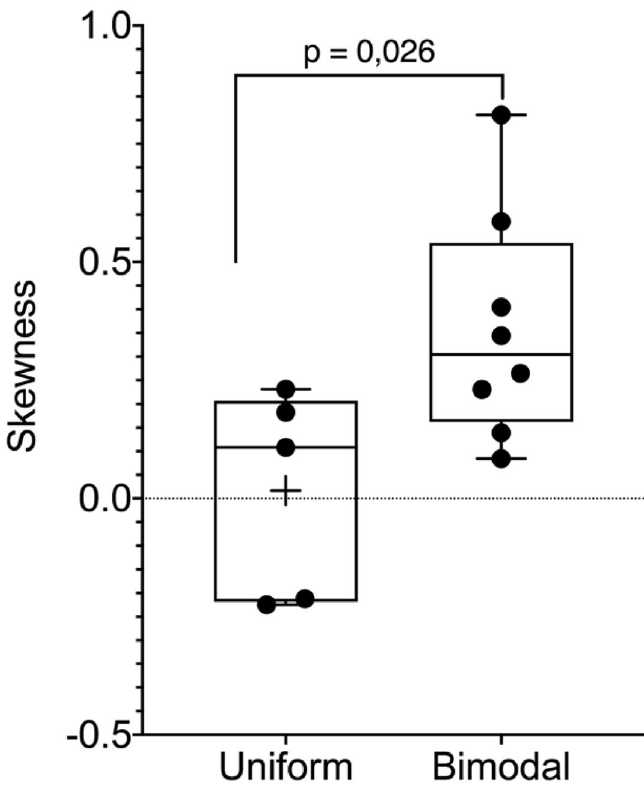
Figure 9. The skewness of the elastic modulus data sets. Uniform—grouped means that represents the skewness of histograms of uniform coatings elastic modulus. Bimodal—grouped means that represents the skewness of histograms of all kinds of bimodal blends elastic modulus. The means of these two groups were significantly different (p < 0.05).